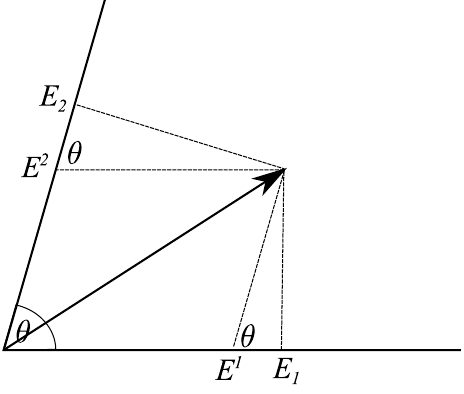
Figure 4. Covariant and contravariant components of E